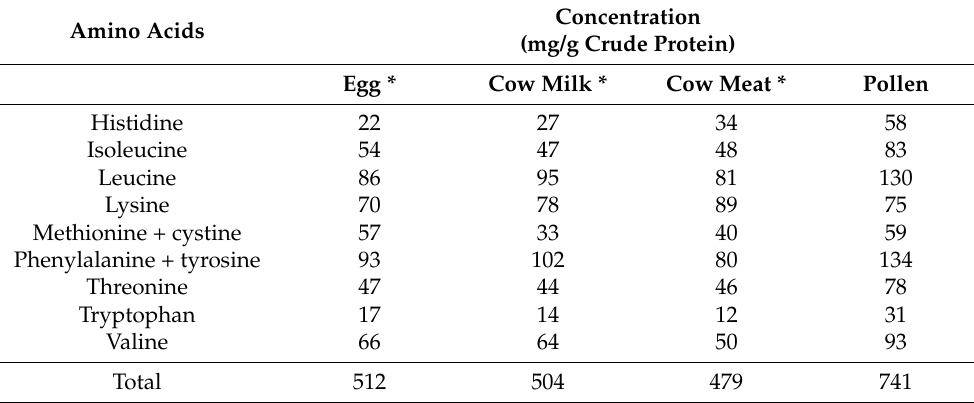
Table 2. The concentration of amino acids (mg/g) quantified in: pollen, egg, cow milk, and cow meat. Amino